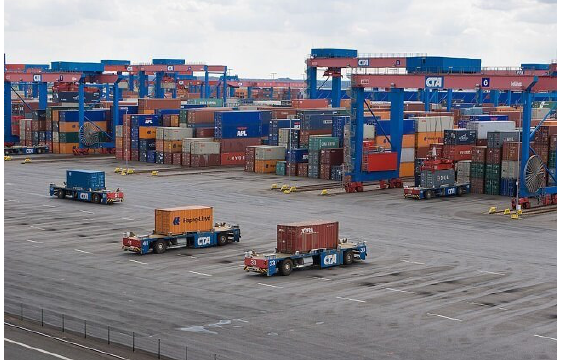
Figure 7 . Fleet of AGVs as part of port operations automation (Credits: